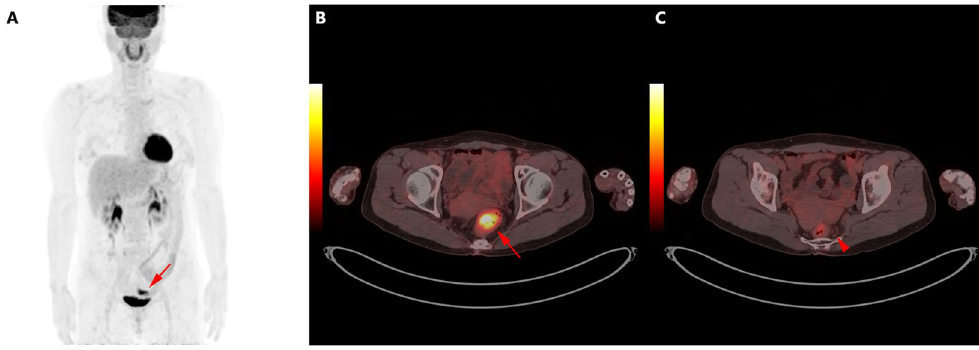
Figure 3. ( A ) Sixty-two-year-old female patient diagnosed with rectal cancer. ( B ) [ 18 F]FDG PET/CT showed that intense [ 18 F]FDG uptake in the rectum (T_SUVmax; 10.7, T_MTV; 13.7 ml). ( C ) Small LNs without significant [ 18 F]FDG uptake were observed in the pericolic space, however, 3 of 24 resected LNs